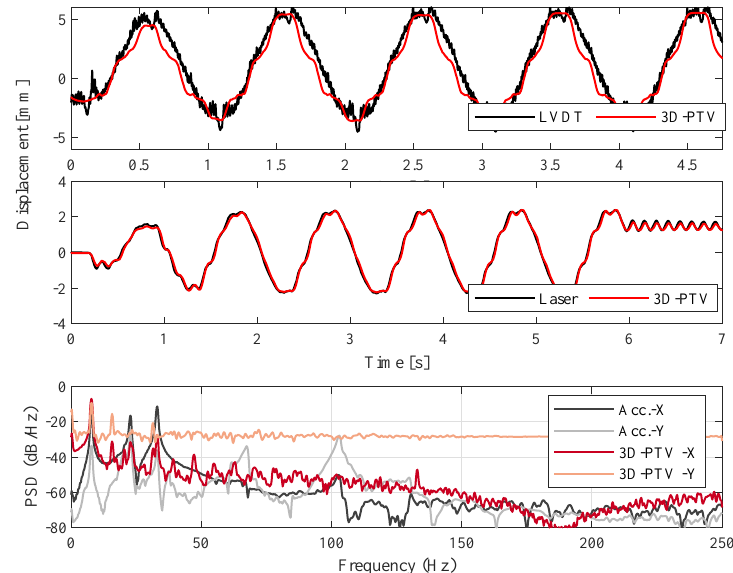
Figure 8. ( Top ) Displacement validation of 3D-PTV against LVDT for a sinusoidal input at shake-table base. ( Middle ) Displacement validation of 3D-PTV against laser distometer for a sinusoidal input at top of the frame. ( Bottom ) Power spectral density validation of 3D-PTV against an accelerometer for a hammer impact excitation at top of the